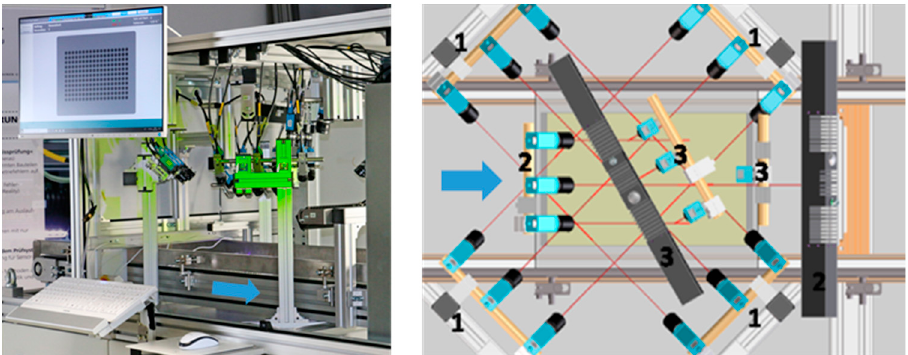
Figure 1. Inspection system with removed front cover plate ( left ); top view on the camera groups 1, 2, and 3 and illuminations ( right ), blue arrow—movement direction.